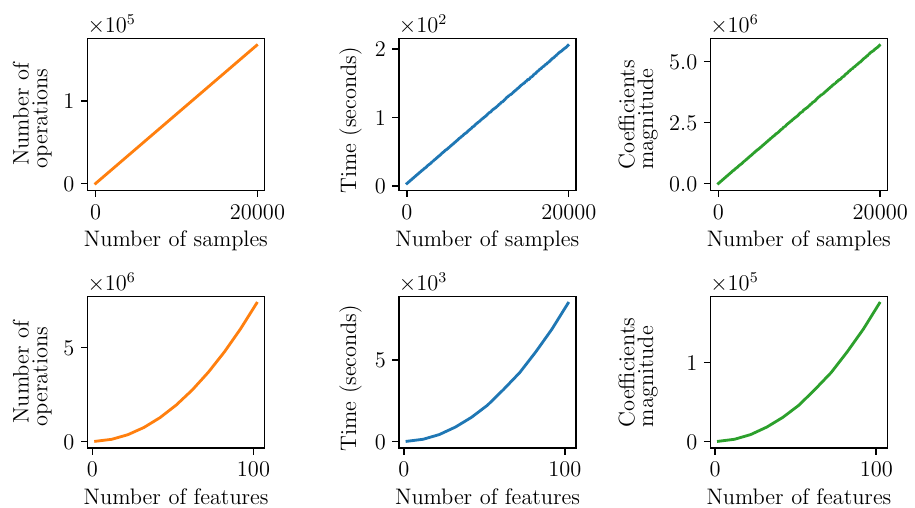
Figure 3. Impact of input data size on the total number of arithmetic operations ( left ), total runtime ( mid ) and maximum value ( right ). The total number of data samples was varied while keeping the number of features fixed ( top ) and the number of input features was varied while keeping the number of samples fixed ( bottom ).